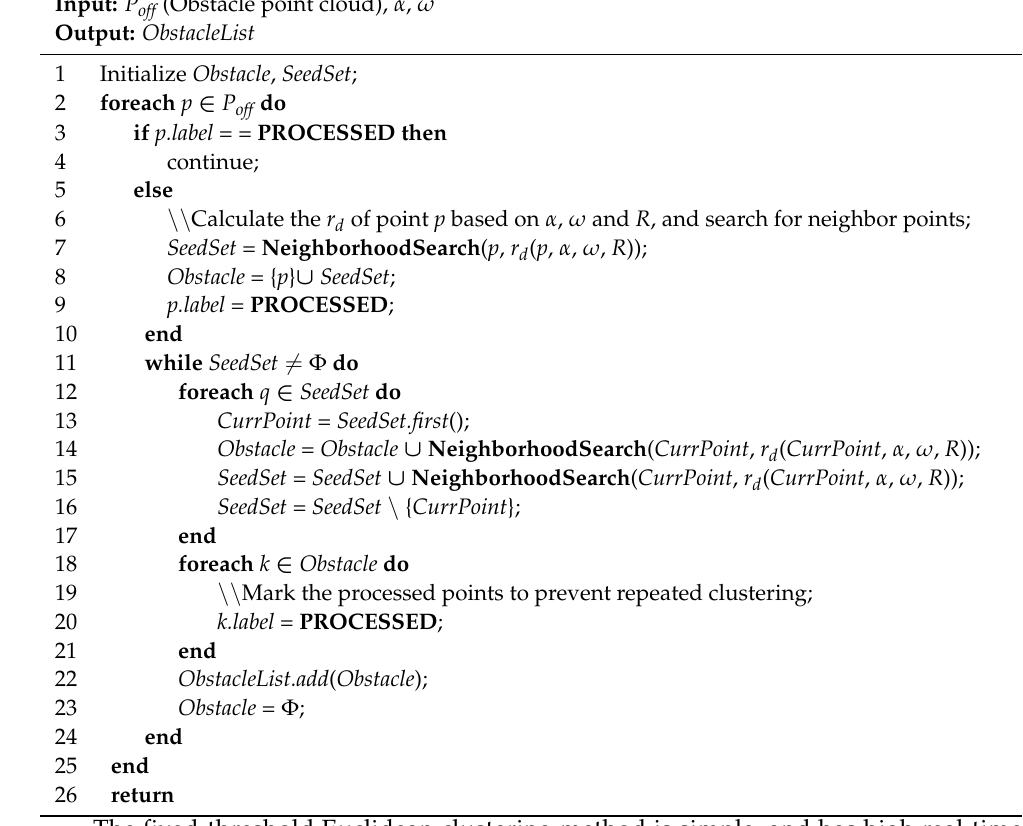
Algorithm 2: Adaptive neighborhood search radius clustering